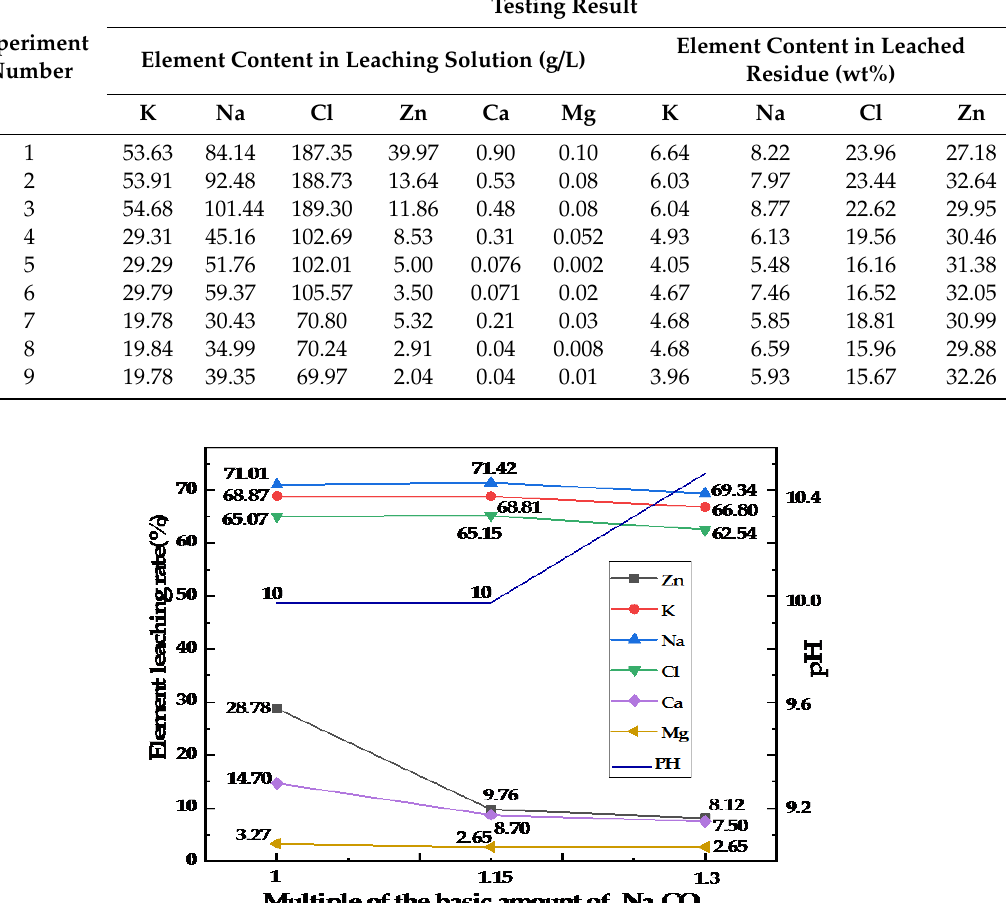
Table 7. Test results for element content in a leaching experiment with Na 2 CO 3.